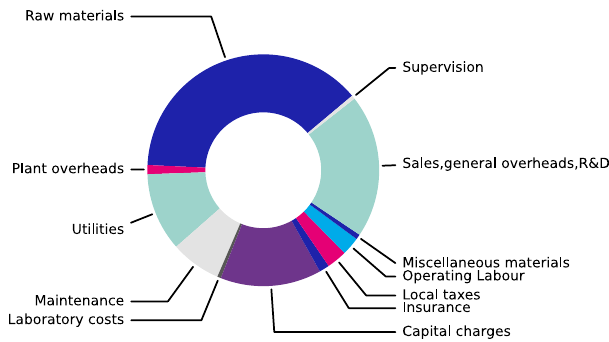
Fig. 12 Cost estimate breakdown. Estimated cost distribution for nano ZIF- 8 production.